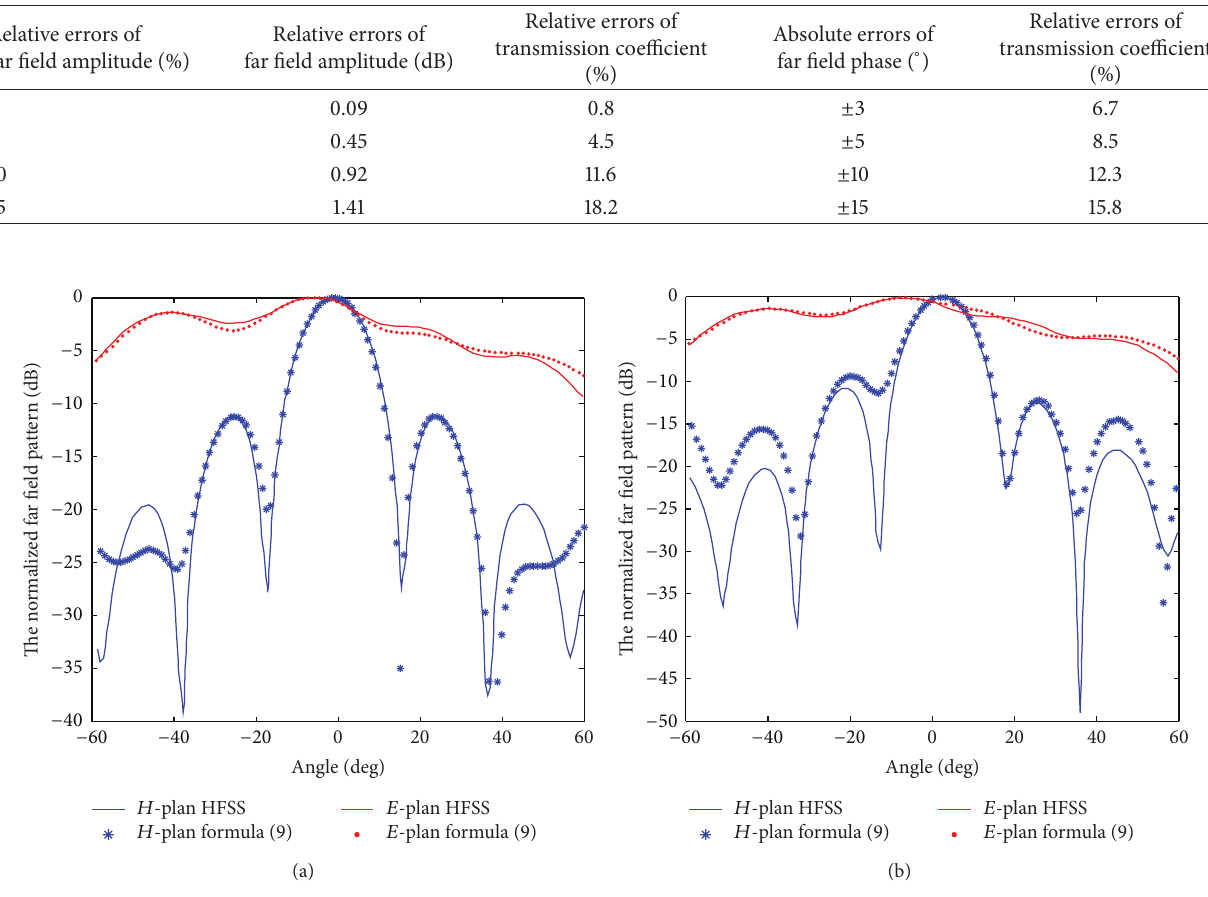
Table 8: Influence of far field data’s error on the transmission coefficient.